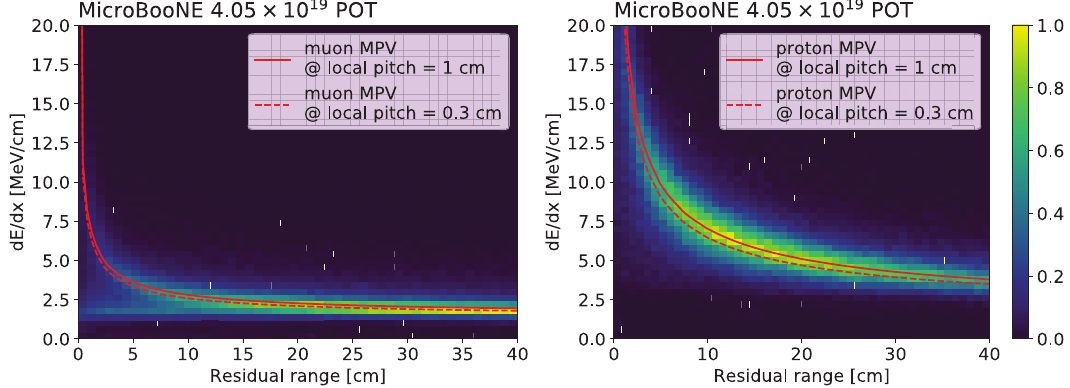
JHEP12(2021)153